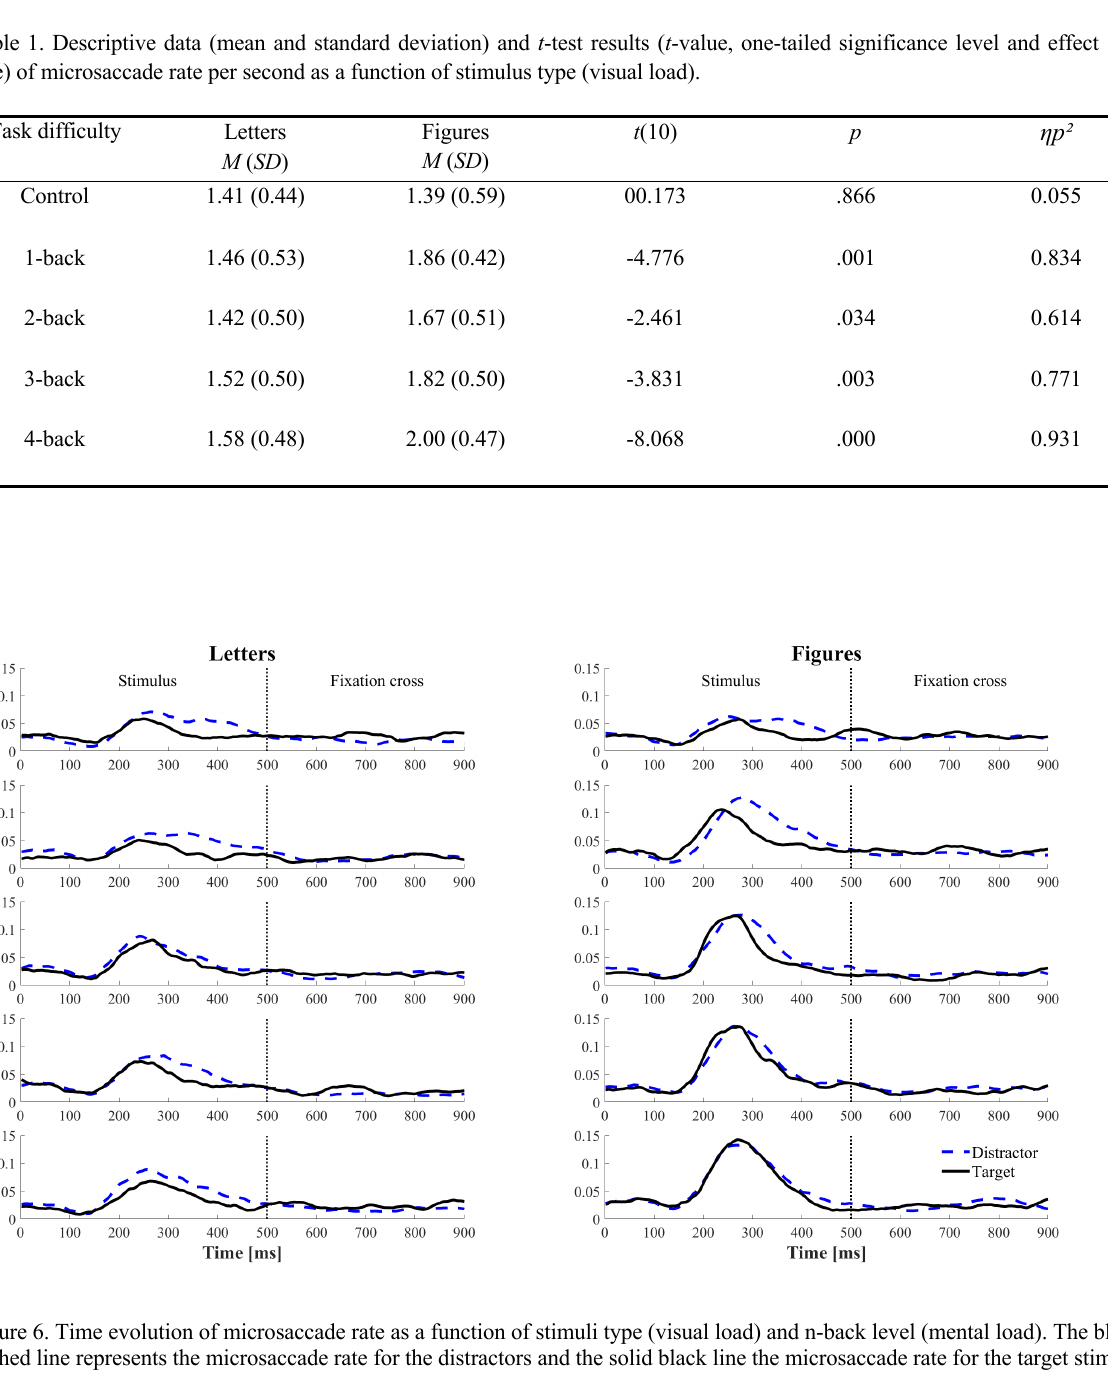
Table 1. Descriptive data (mean and standard deviation) and t -test results ( t -value, one-tailed significance level and effect